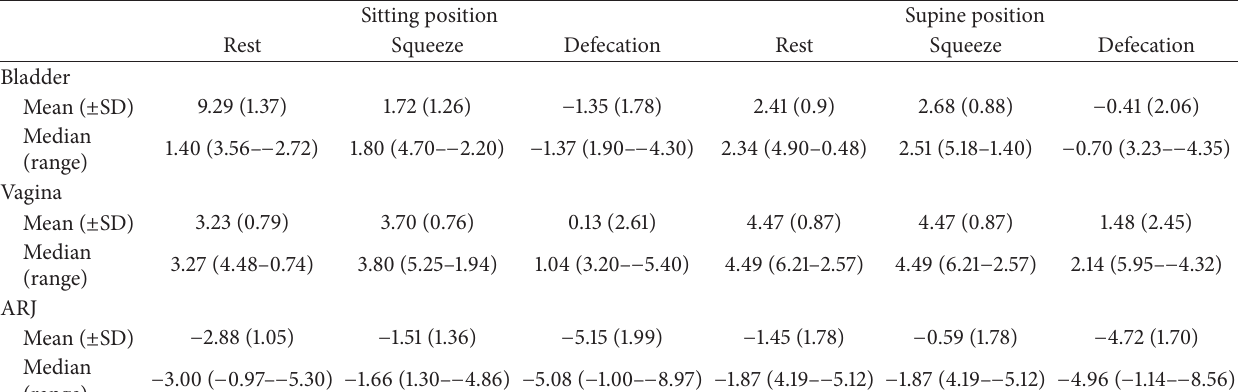
Table 1: Synthesis of the measures (in cm) of pelvic organs in respect to the PCP, in rest, squeeze, and defecation phases in both sitting and supine examinations in all patients. SD: standard